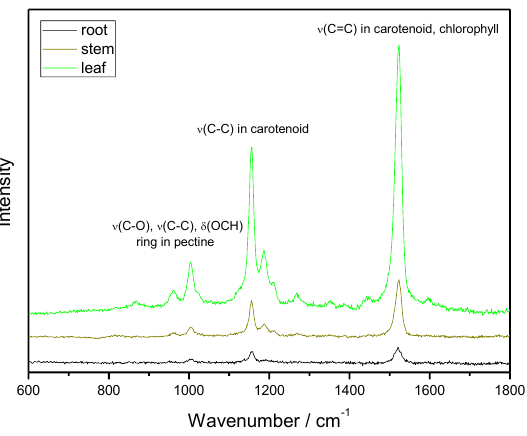
Fig. 6. The Raman spectroscopy results for the plant parts visible in Fig. 5, for the ones growing on a substrate containing